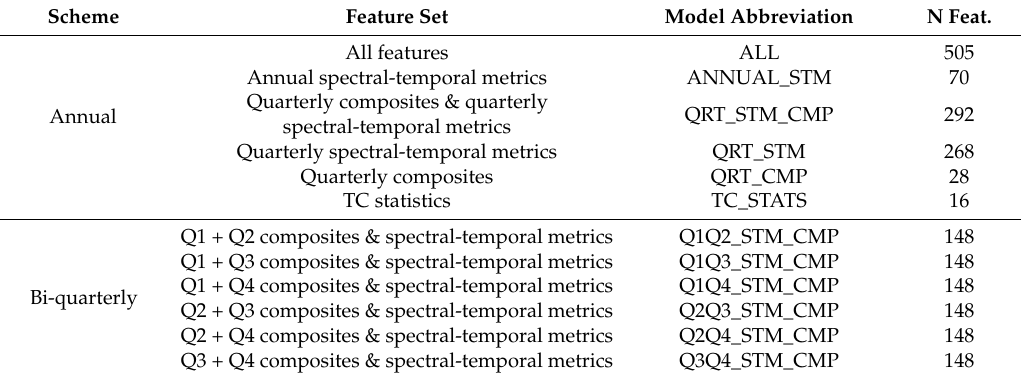
Table 2. Feature subsets and abbreviations, as well as total number of features, and number of features including the four auxiliary variables (latitude, longitude, elevation, and